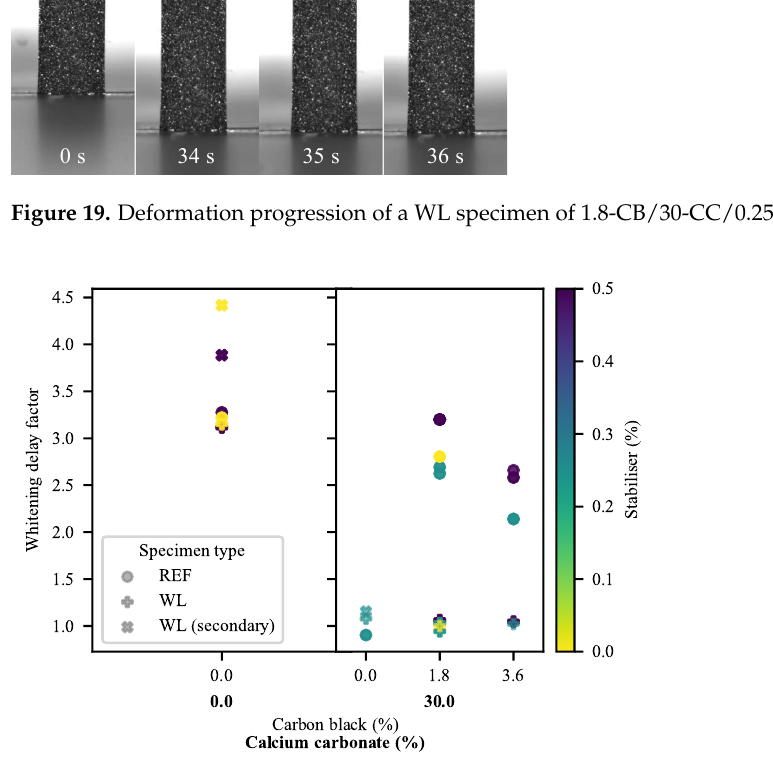
Figure 20. Delay factor of whitening from yield as a function of specimen type and CC, CB and SP